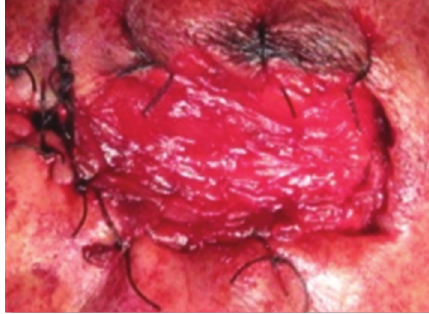
Figure 8: Postoperative